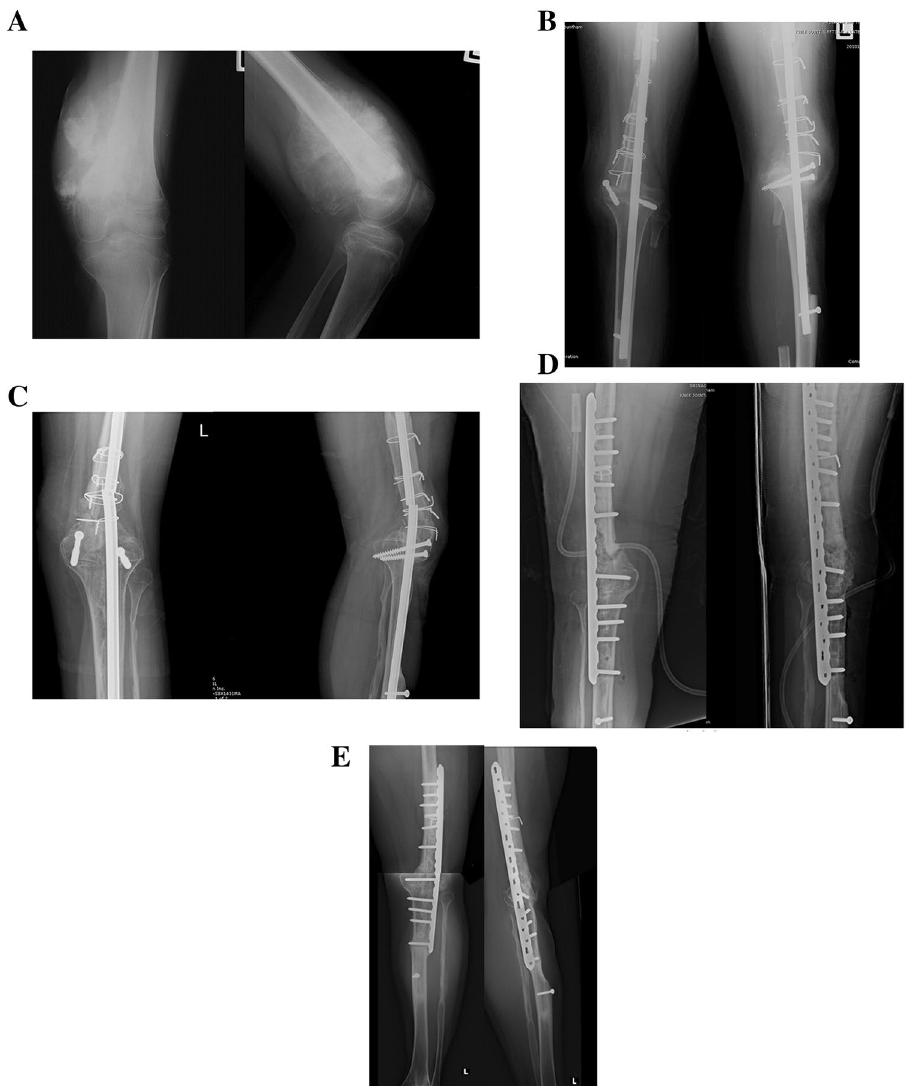
Figure 1. Thirteen-year-old male with osteosarcoma of the distal femur with extensive muscle involvement. ( A ) preoperative anteroposterior and lateral radiograph. ( B ) Postoperative radiograph after wide resection and reconstruction with tibial turn-up and augmentation with nonvascularized fibula graft (resection arthrodesis). ( C ) Break of intramedullary nail occurred 2 years postoperatively. ( D ) Revision surgery with plate and screws. ( E ) Eight years after the index procedure with bone